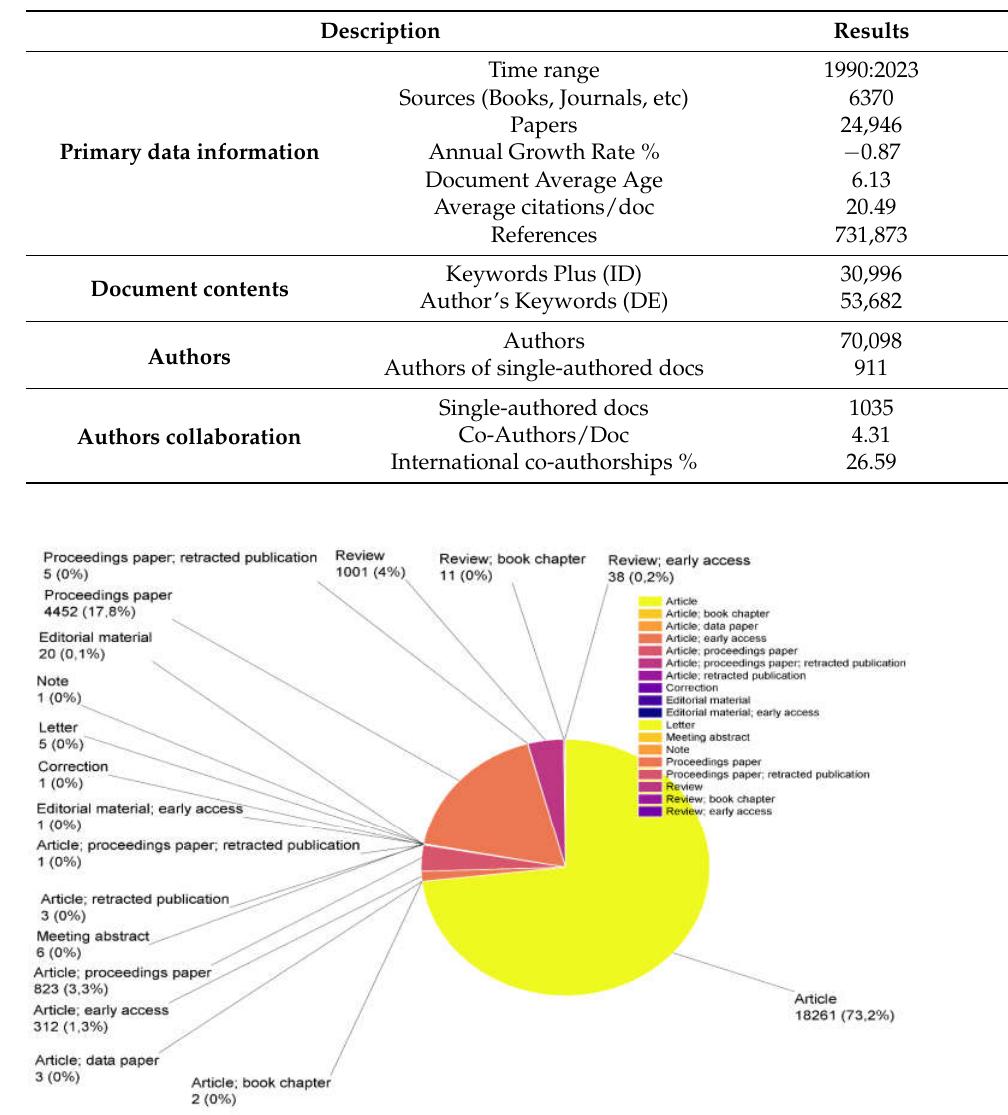
Table 2. Main information.